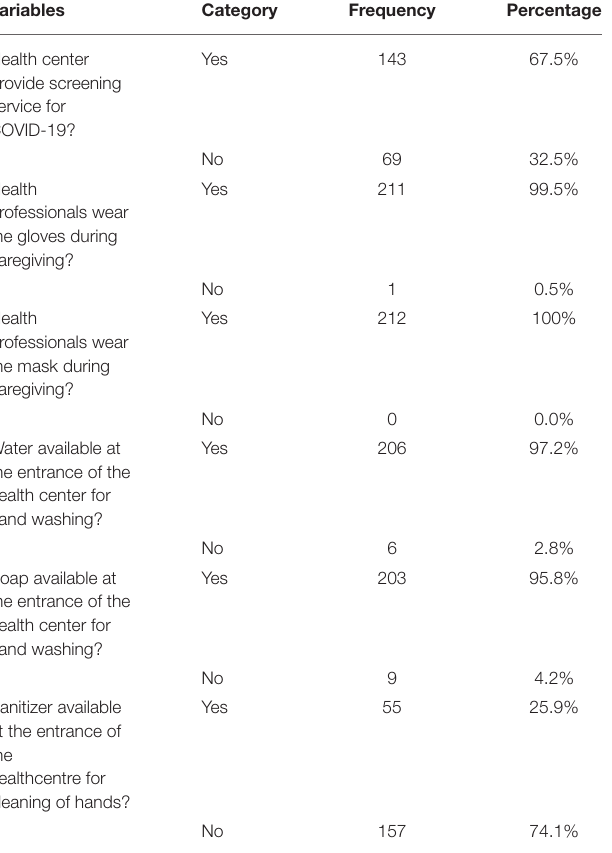
TABLE 6 | Response of the study participants to the precautions of health facilities for COVID-19 protection, Addis Ababa, Ethiopia, May 2021. Variables